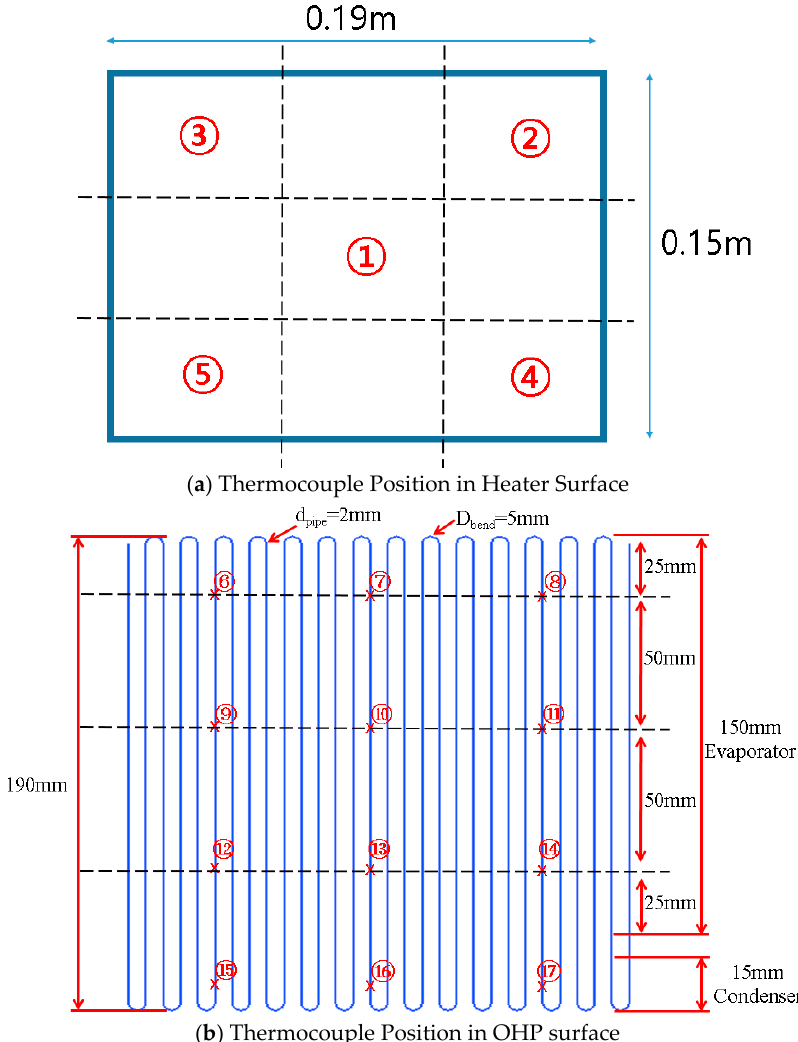
Figure 3. Thermocouple Positions.